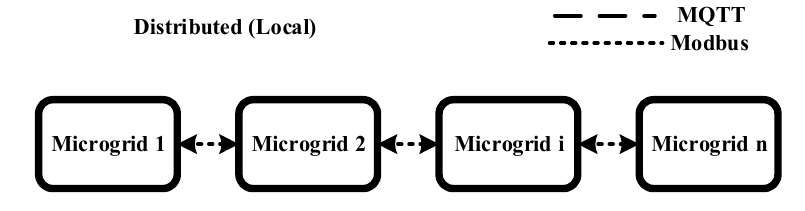
Figure 9. Distributed communication mode.